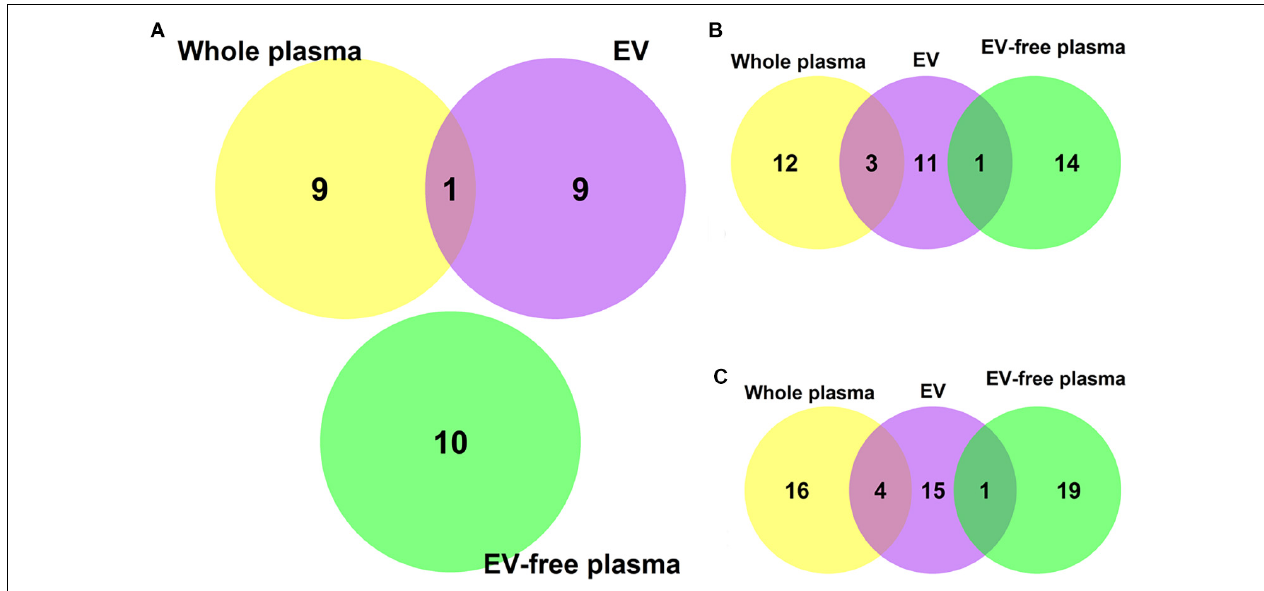
FIGURE 2 | The Venn Diagram of the top 10, 15, and 20 discriminative microRNAs in whole plasma, EV and EV-free plasma. (A) The overlap among the top 10 microRNAs. There was only one overlapped microRNA between whole plasma and EV. The overlap microRNA was hsa-miR-5010-5p. (B) The overlap among the top 15 microRNAs. (C) The overlap among the top 20